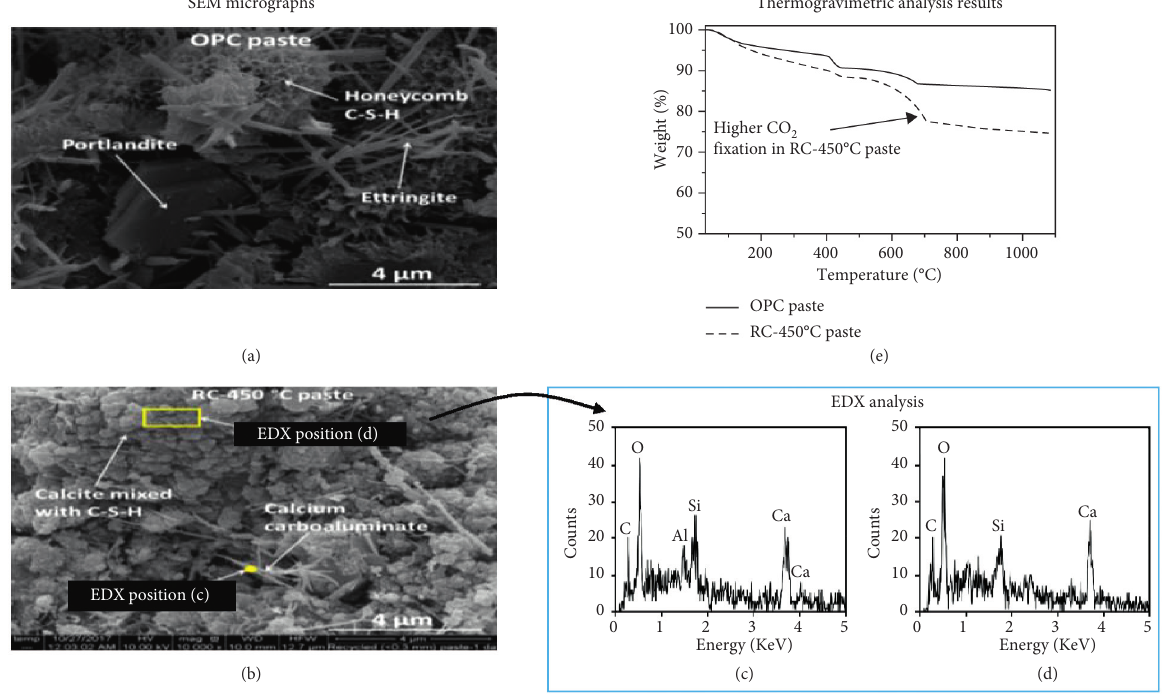
Figure 9: Comparison of SEM micrographs and TGA along with EDX analysis on specified locations for OPC and recycled cement (RC) 450 ° C (modified after